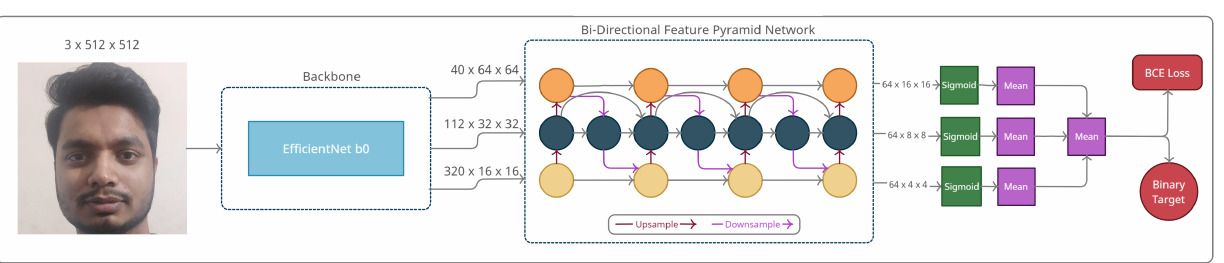
Figure 4. The architecture of our baseline bi-directional feature pyramid network (BiFPN) model, Bi-FAS.